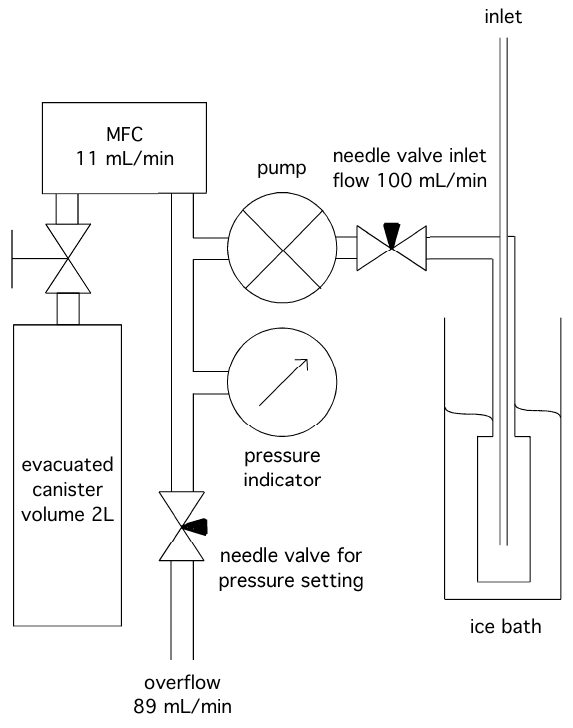
Fig. 2. Schematic drawing of the gradient air sampling units. Before filling the evacuated 2l sample canister, the air passes through an ice bath to reduce the humidity. The sample flow is set to 11mlmin − 1 by a Mass Flow Controller (MFC). Typically samples were taken over a period of 06:00h.